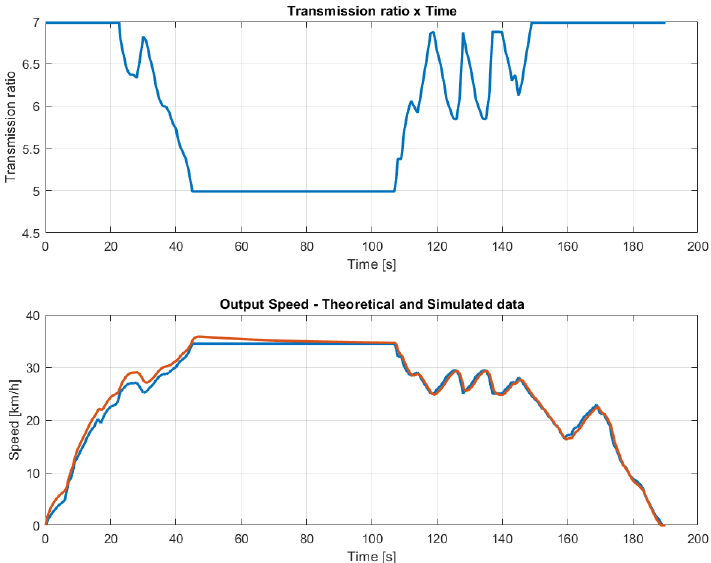
Figure 6. Transmission ratio and output speed comparison for a general driving